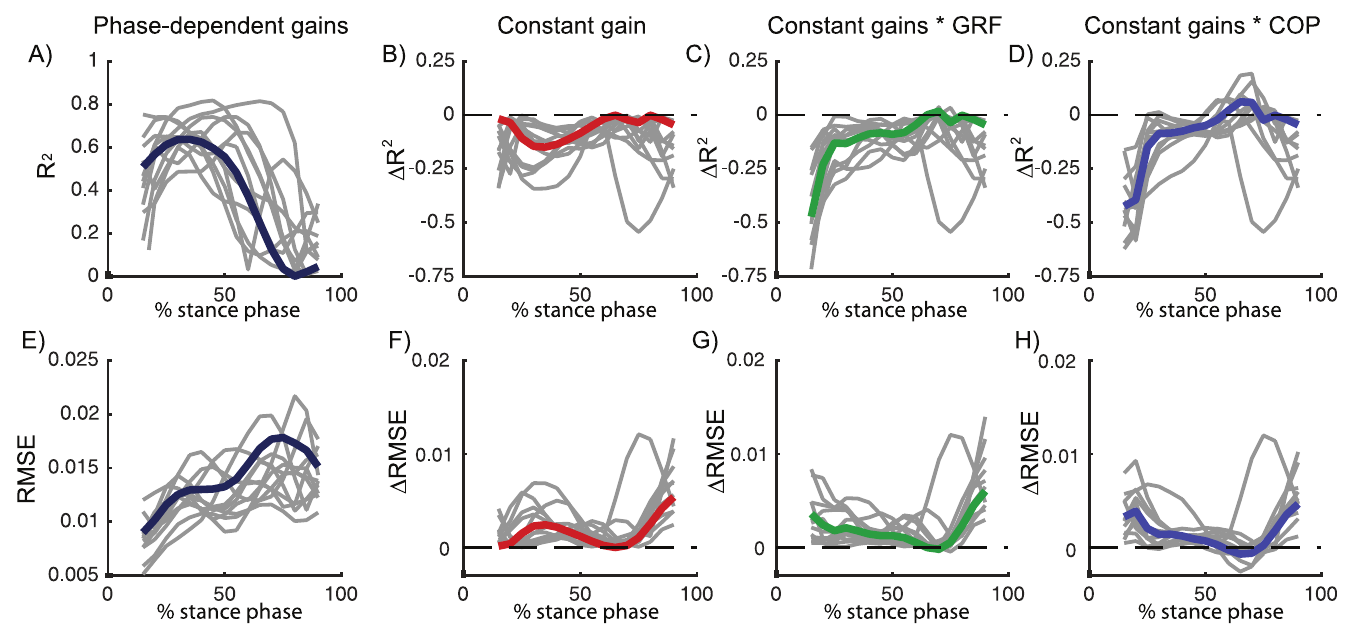
Fig 9. Continuous treadmill perturbations walking (data from [27]). R 2 and RMSE of the linear regression between COM kinematics and ankle moment in a model with phase-dependent feedback gains (A, dark blue). Relative to the model with phase-dependent gains, R 2 and RMSE values increased in models with constant feedback gains (B, red), constant feedback gains multiplied by vertical ground reaction force (C, green) and constant feedback gains multiplied by the COP position (D, blue). Data pooled over all subjects are visualised in color and results for individual subjects are visualised in gray. A similar increase in RMSE and decrease in R 2 was found in the three models, indicating that the quality of fit did not increase with information from the vertical force or COP. Results of the statistical analysis can be found in S1 Table in Fig 7.